Question: Summarize what this figure shows in one sentence.
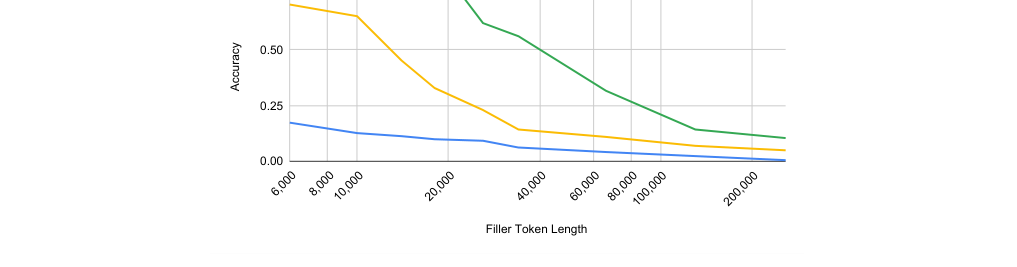
Answer: PassKey Accuracy: FAM maintains performance with long sequences, outperforming BSWA, RMT and AutoCompressors.